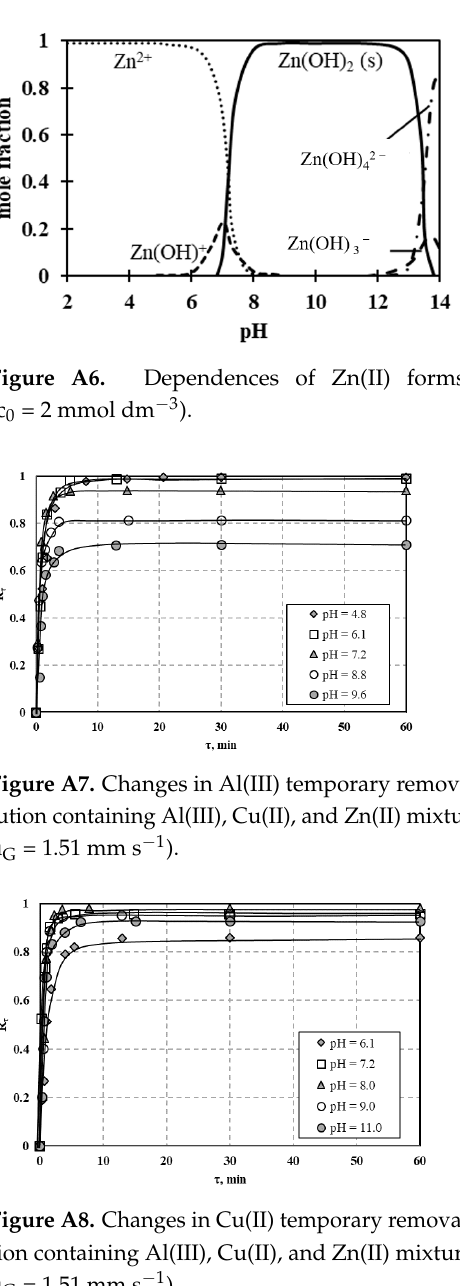
Figure A5. Dependences of Zn(II) forms on the pH value of the aqueous solutions (c 0 = 0.15 mmol dm − 3 ).